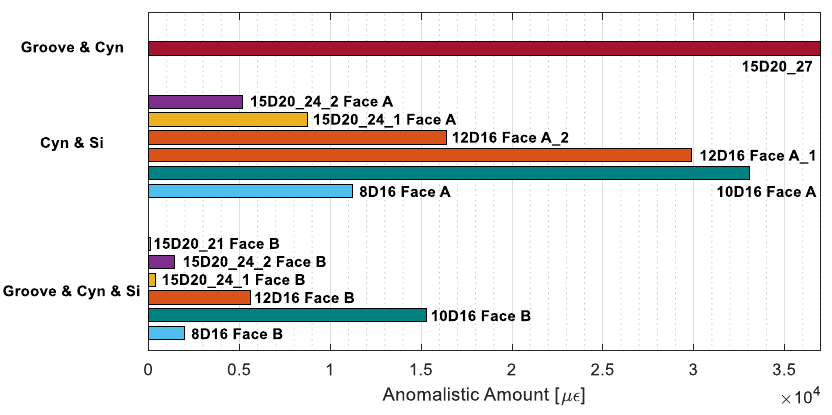
Figure 21. Total amount of anomalistic readings grouped per bonding technique used.